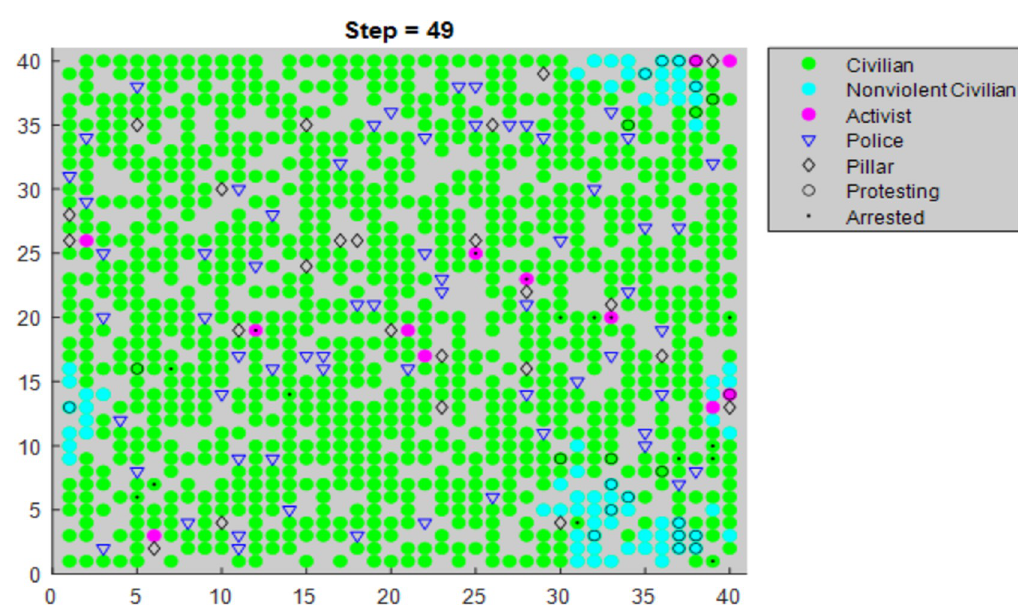
Fig 1. Example of resistance movement at an advanced